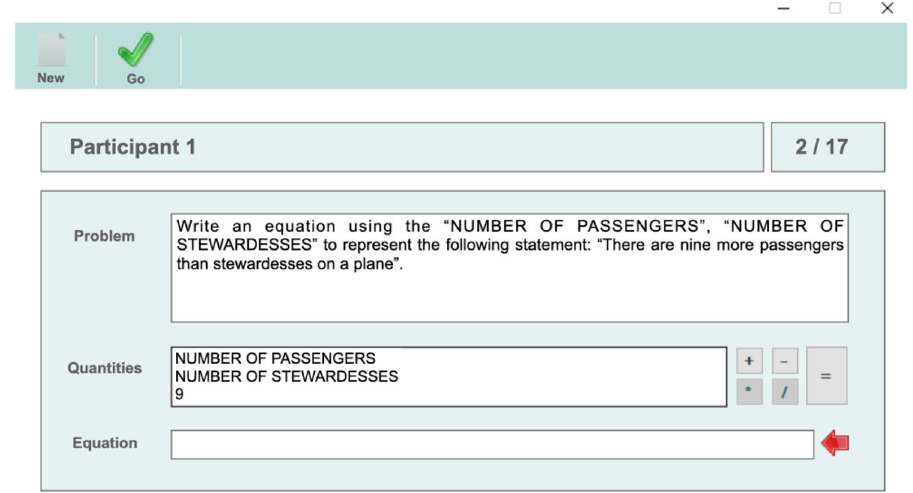
Figure 4. Application implemented for data collection in studies on the reversal error 7 . Note By clicking on each of the variables ( quantities ) and operation signs (+, −, *, / and =; right to quantities ), participants had to write the equation that corresponded to the statement of the problem. The rectangle called Equation contains the variables they clicked. After that, they validated their equation by the Go